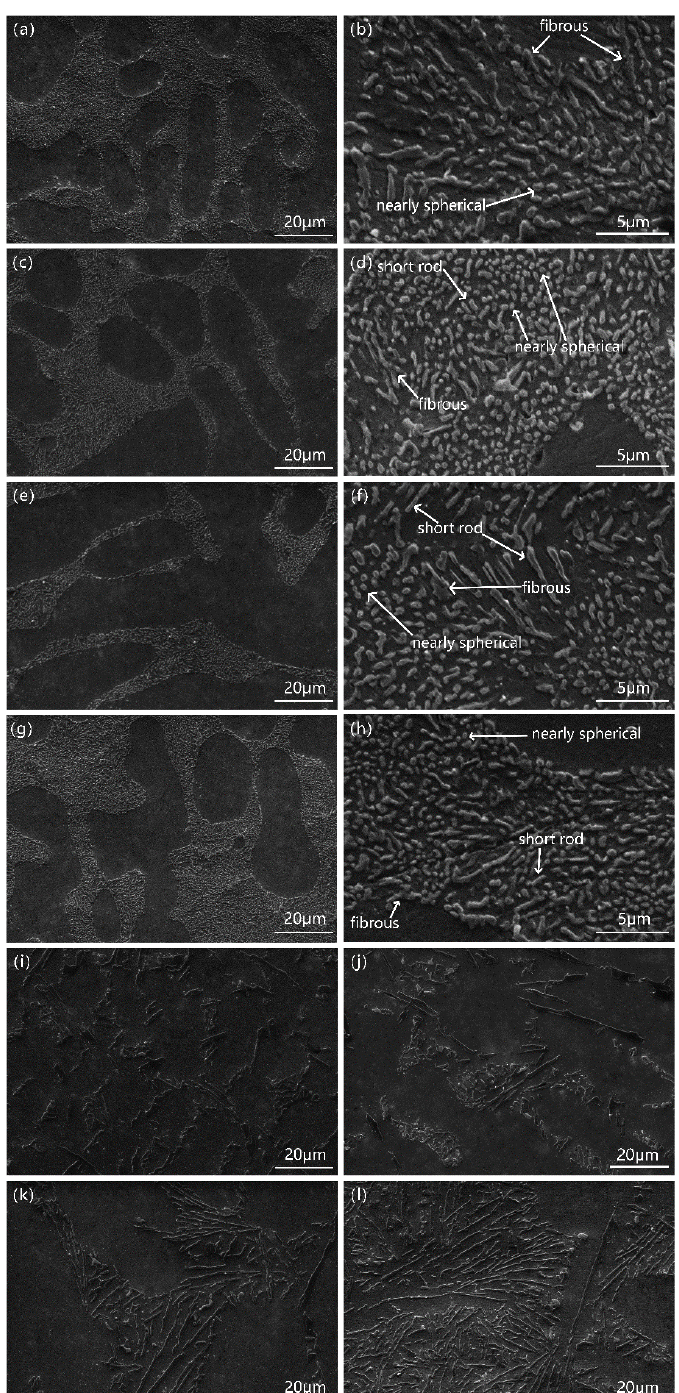
Figure 4. SEM microstructure of eutectic silicon in Al-8Si alloys under different cooling rates: ( a ) Sr + 234 °C/s, ( b ) amplification of Sr + 234 °C/s ( c ) Sr + 136 °C/s, ( d ) amplification of Sr + 136 °C/s, ( e ) Sr + 63.2 °C/s, ( f ) amplification of Sr + 63.2 °C/s, ( g ) Sr + 46.2 °C/s, ( h ) amplification of Sr + 46.2 °C/s, ( i ) 234 °C/s, ( j ) 136 °C/s, ( k ) 63.2 °C/s, ( l ) 46.2 °C/s.